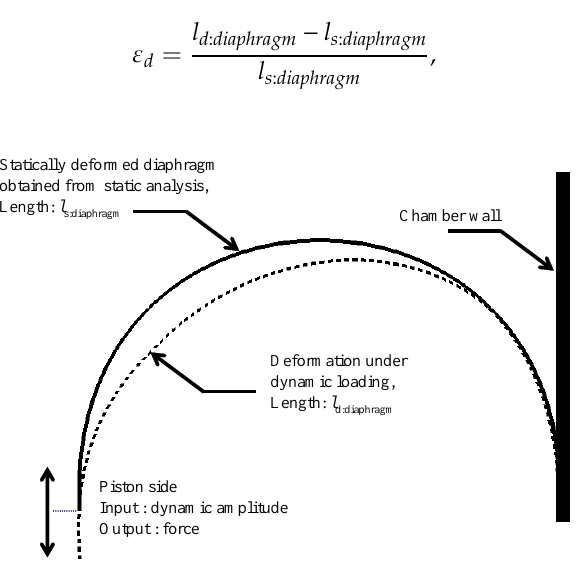
Deformation under dynamic loading,